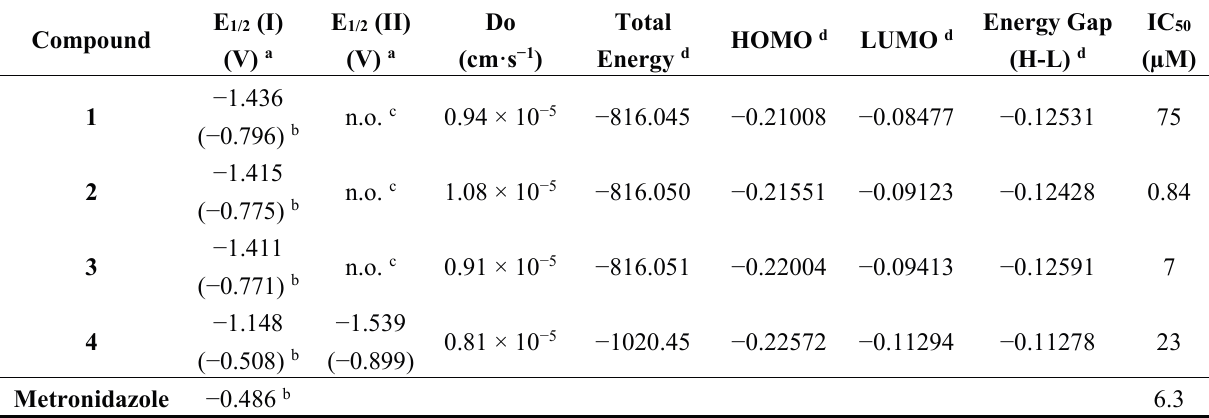
Table 2. Electronic parameters and half inhibition concentration (IC 50 ) values expressed in µM for the nitrobenzene hydrazone compounds 1 – 4